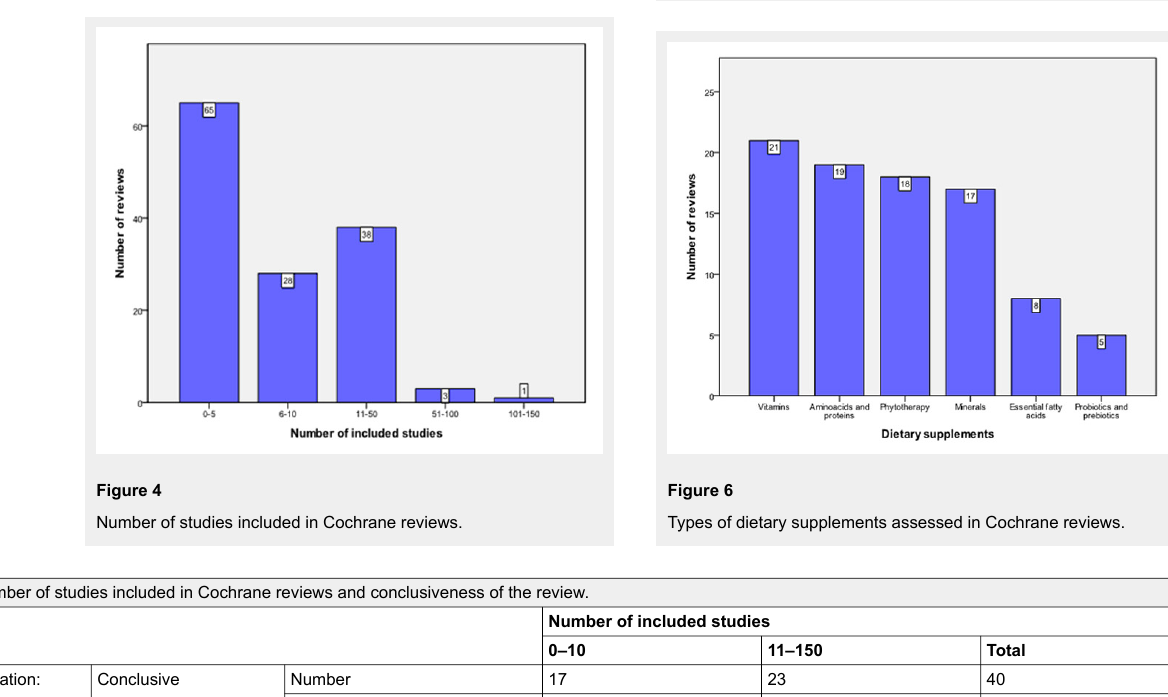
Types of intervention assessed in Cochrane reviews.